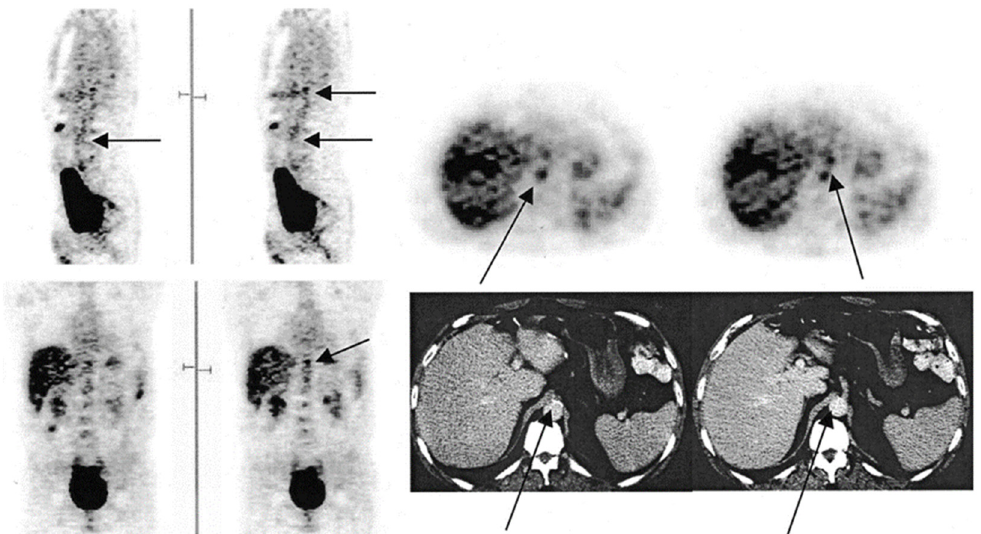
Figure 1. FDG-PET images illustrating the foci of FDG uptake along the aorta. In the sagittal view, the arrow in the left image indicates the abdominal aorta, while the top arrow on the right points to the budding superior mesenteric artery. In the transverse view, the bottom and top arrows indicate the abdominal aorta and budding superior mesenteric artery, respectively. In the coronal view, the arrow points to the budding mesenteric artery. In the CT image, the left arrow points to calcification along the abdominal aorta, while the right indicates to the budding superior mesenteric artery (from Yun et al. [23] with